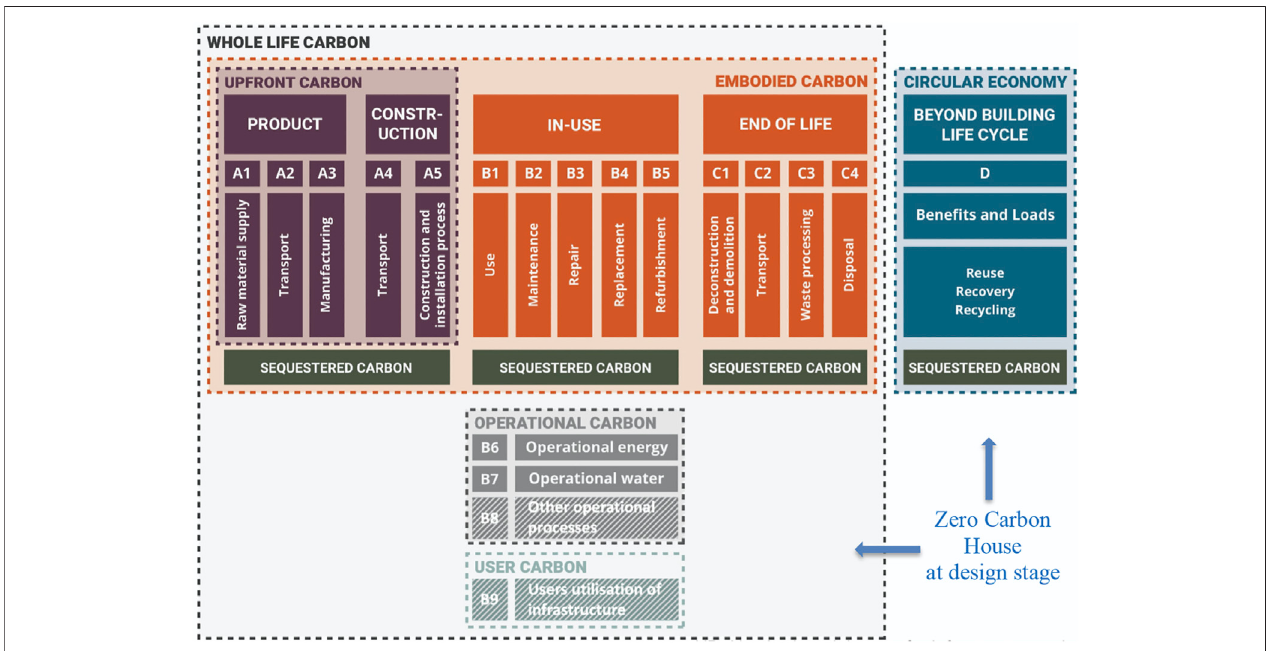
FIGURE 1 | Whole Life Carbon categories (WLCN, 2021), based on (RICS, 2017). Hatched areas relate to infrastructure.